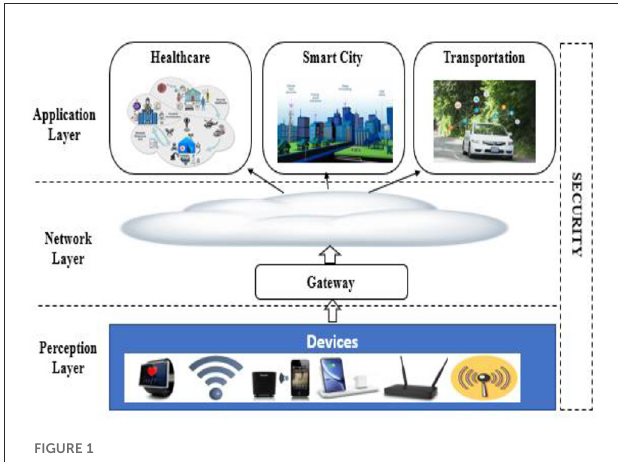
FIGURE1 The Internet of Things design pattern (Fenanir et al.,